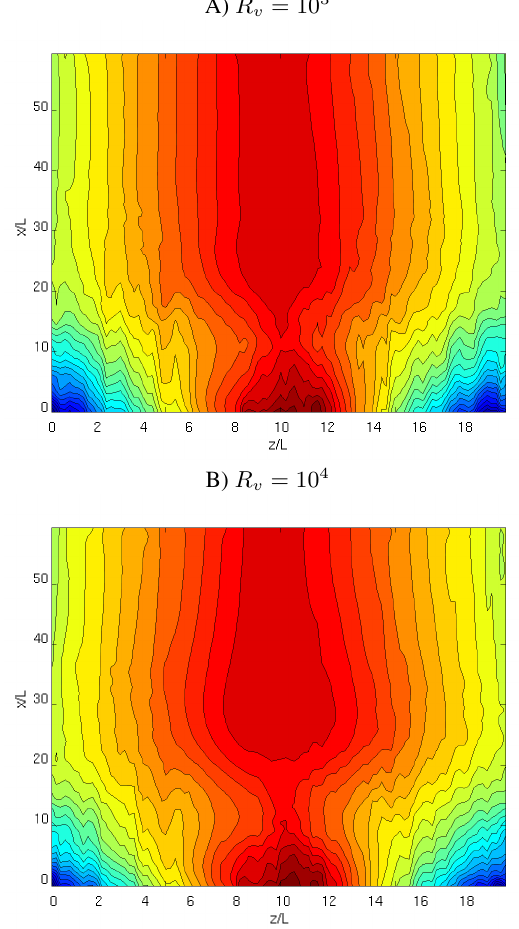
Fig. 9. Non-linear evolution of the initial 2-D helmet streamer equi- librium. Contours of the vector potential A y , representing magnetic surfaces, at time t/τ A = 200